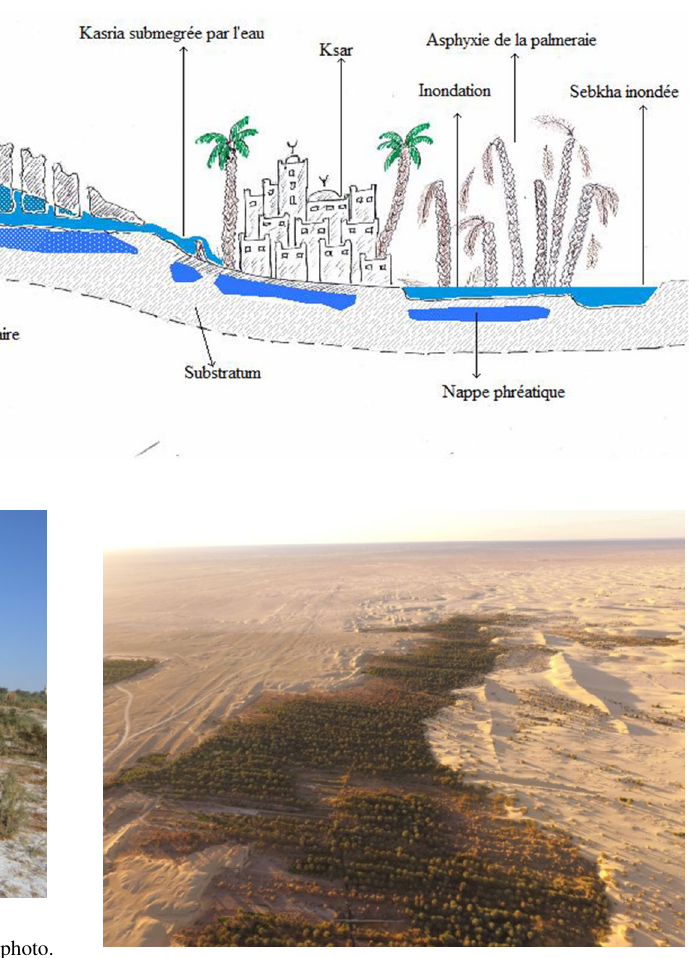
Fig. 13 An aerial view of the advance of the dunes on the palm grove of Bouda. (photo. Authors 2018)